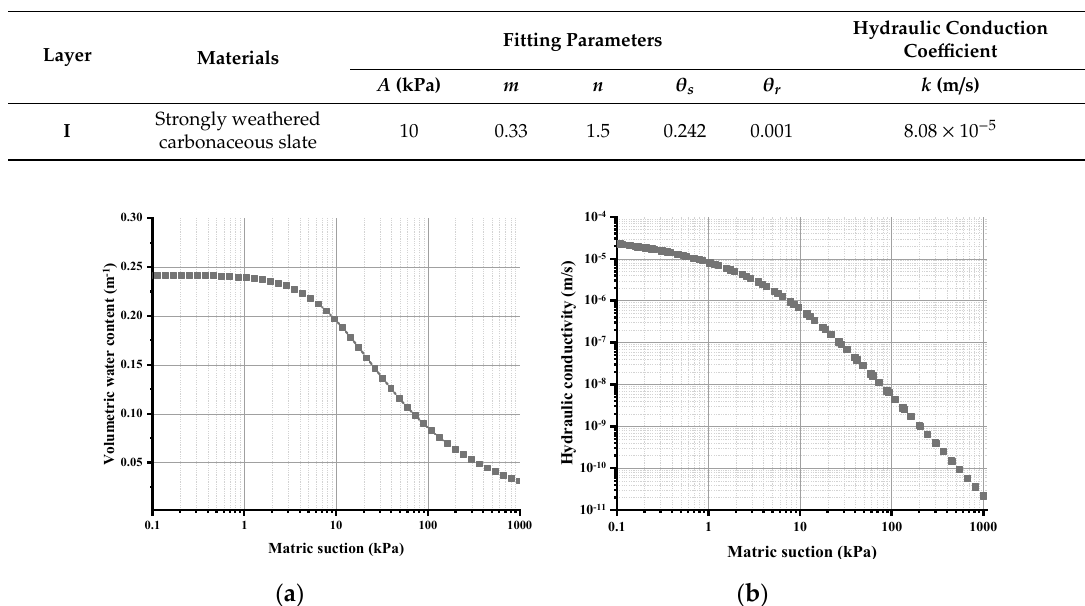
Figure 6. ( a ) Water retention curve; ( b ) hydraulic conductivity curve. Table 1. Parameters of the water retention curve.